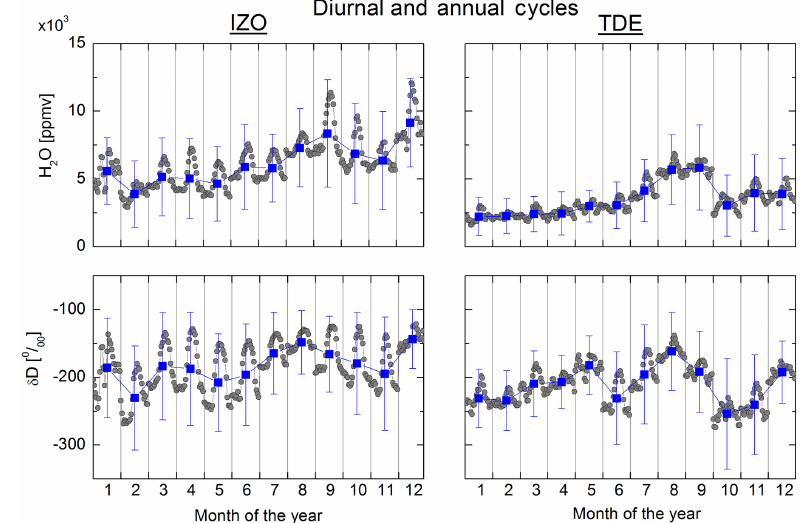
Figure 3. The mean diurnal cycle and annual cycles of H 2 O- δ D (left panels for IZO and right panels for TDE). Grey dots show the mean diurnal cycles for each month (mean value for each hour of the day) and the blue squares the annual cycle (mean and standard deviation of all observations that fall within an individual